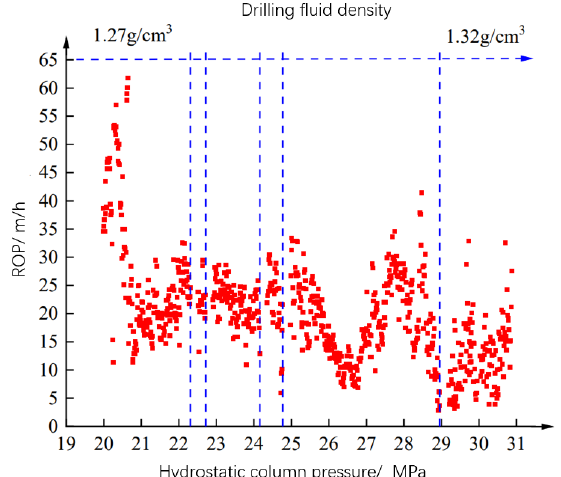
Figure 7. Relationship between ROP and drilling fluid density.